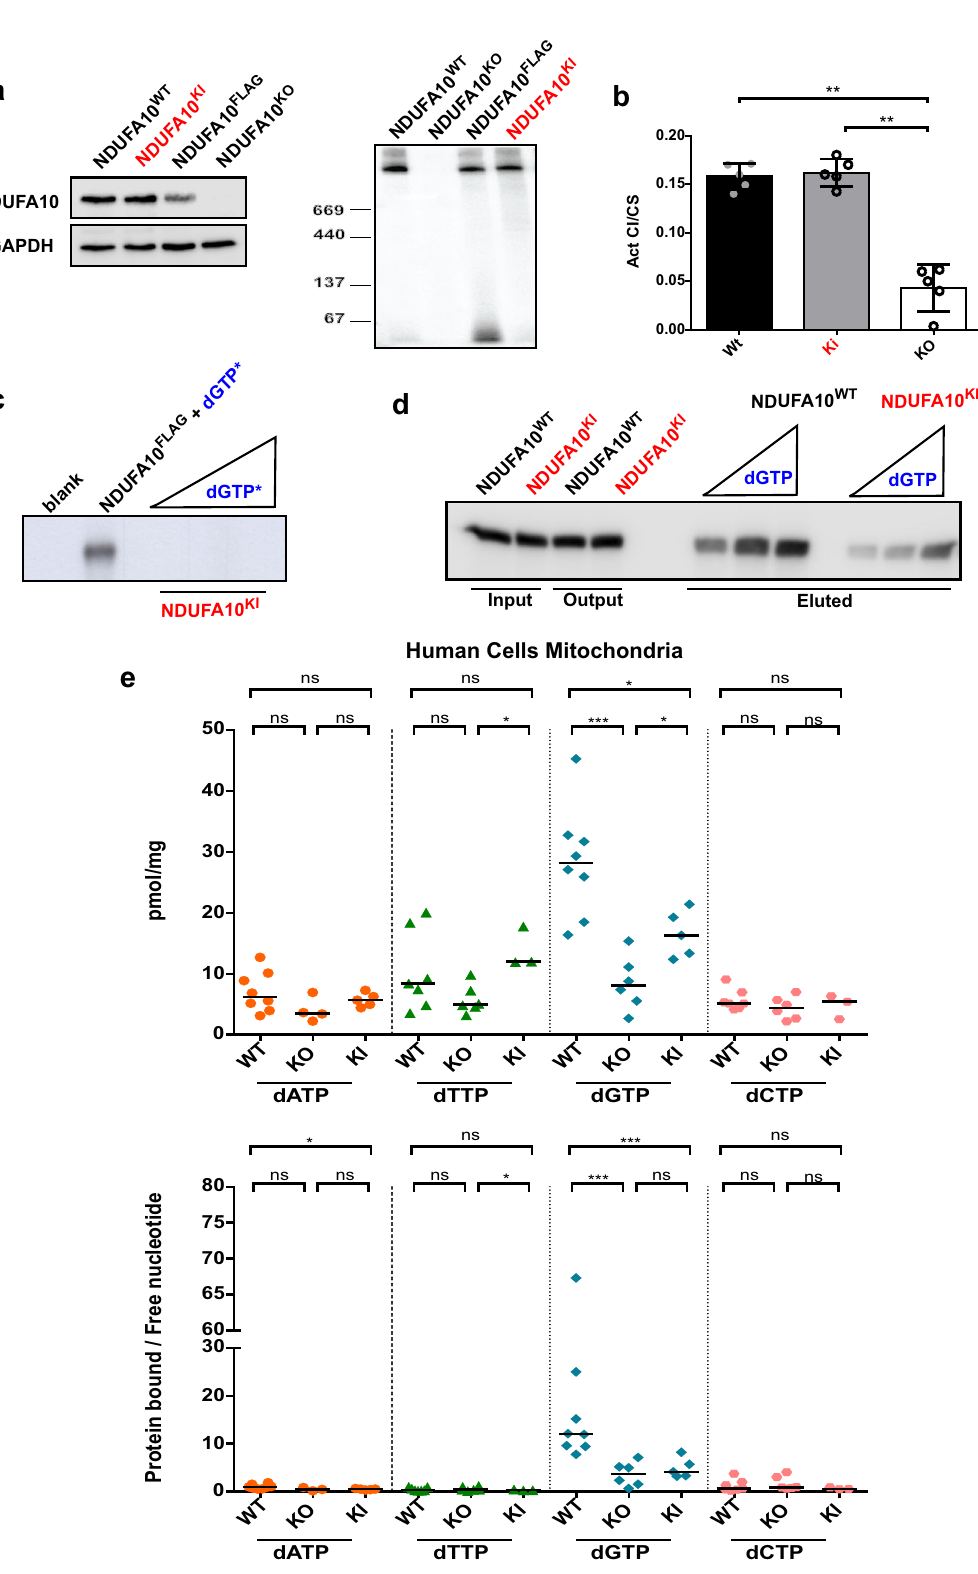
comparison with deoxycytidine kinase, E160 is predicted to directly interact with the magnesium ion required for catalysis and R161 would be part of the active site that is believed to play a role in the deprotonation of the 5 ’ -OH group of the deoxyribose 40 . Mutations affecting the equivalent position in dGK showed decreased af fi nity for substrates and low catalytic activity 41,42